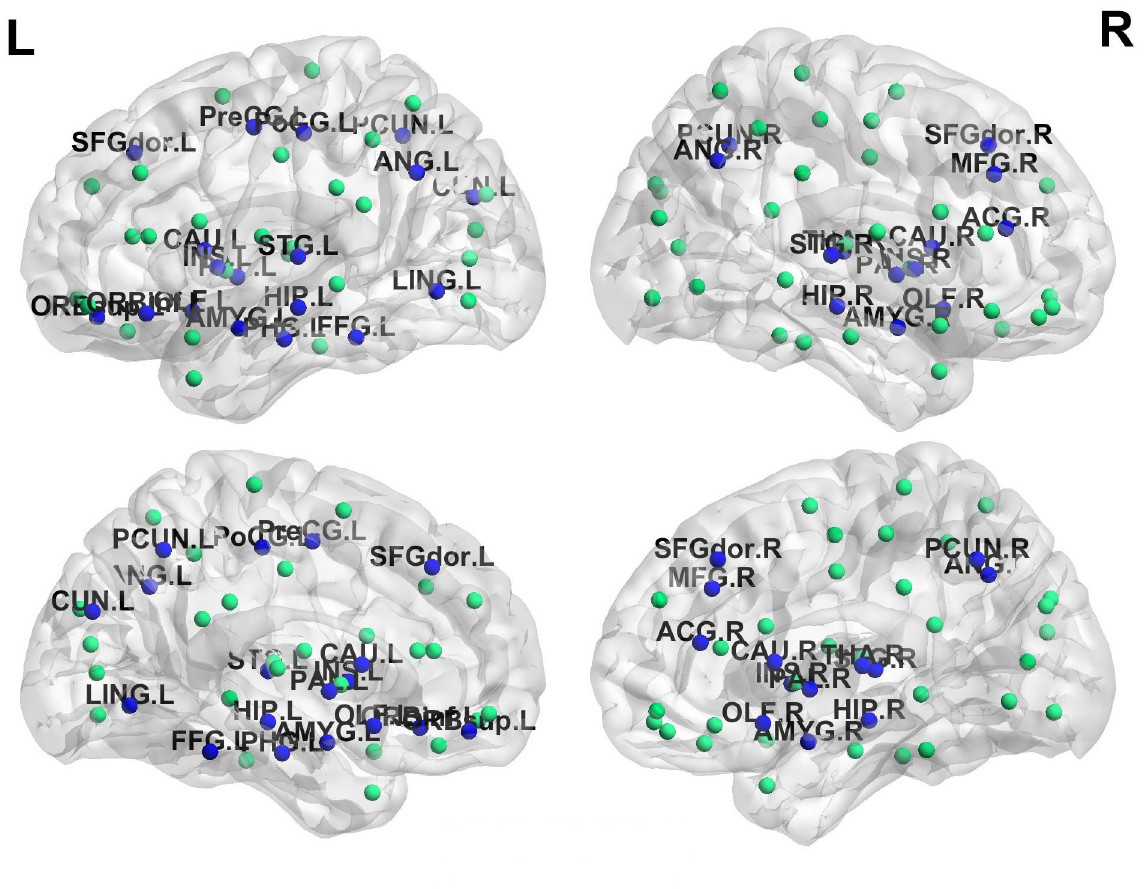
Fig 2. Average accuracy calculation for the decision-level fusion scheme.